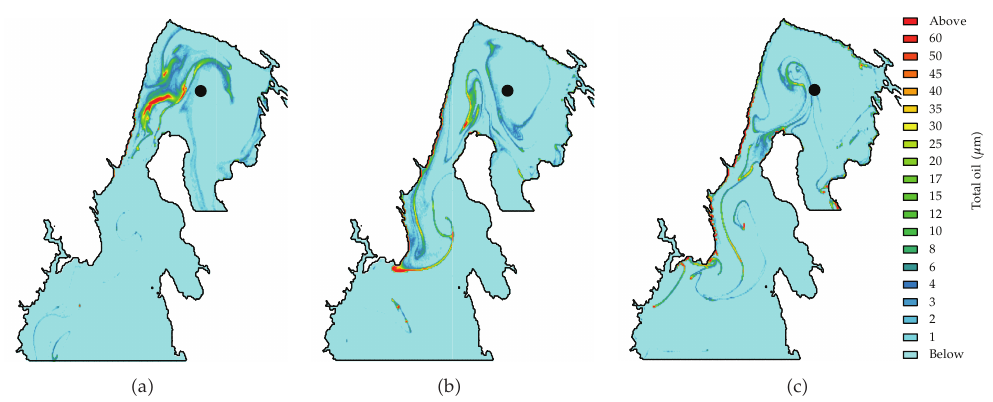
Figure 12: Oil pollution clouds for the 108th (cid:4) a (cid:5) , 150th (cid:4) b (cid:5) , and 192nd (cid:4) c (cid:5) hours after the spill onset at the position 2 (cid:4) center of Rijeka Bay—black rectangle (cid:5) in the summer period (cid:4) 21/7/2008–31/7/2008 (cid:5) .